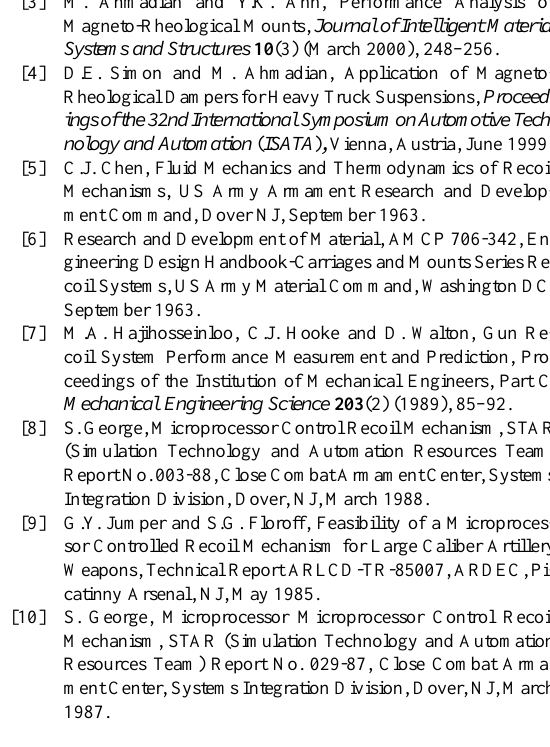
Fig. 11. Possible closed-loop recoil control using MR dampers, to reduce recoil forces while maintaining a short recoil stroke.